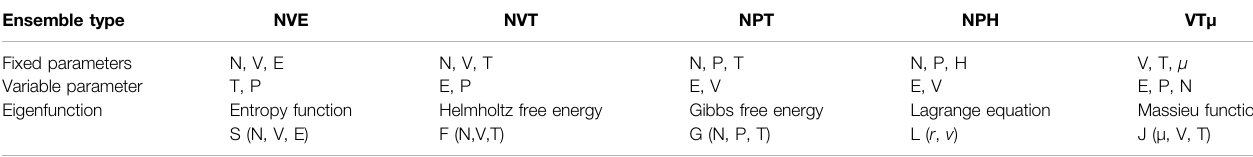
TABLE 1 | Common ensemble classi fi cation and their properties under macro constraints. Ensemble